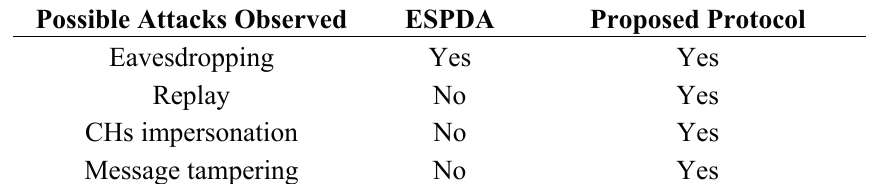
Table 4. Possible attacks addressed, in comparison with other secure data aggregation